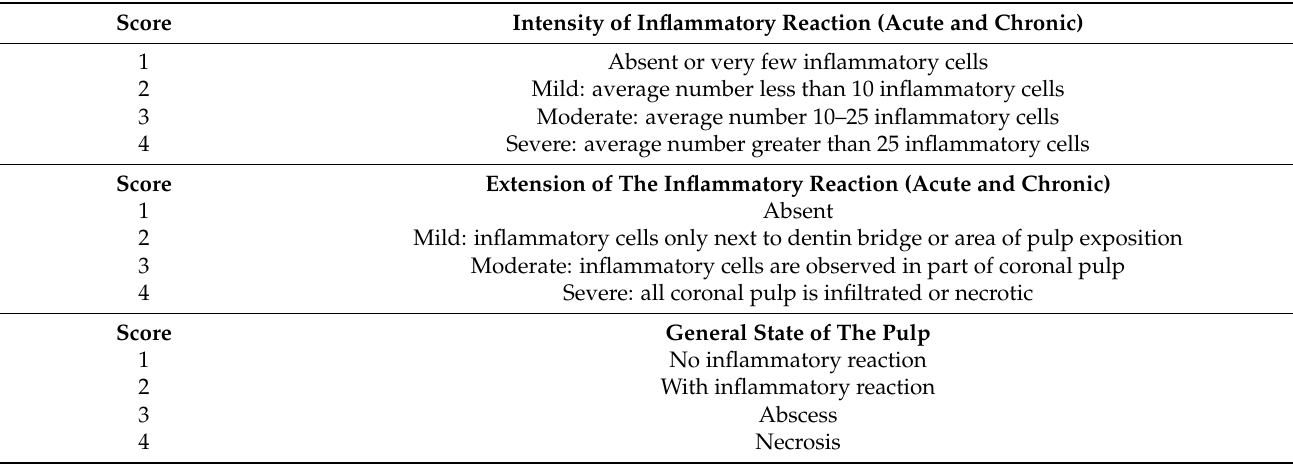
Table 3. Scores used for the evaluation of the inflammatory response of pulp.